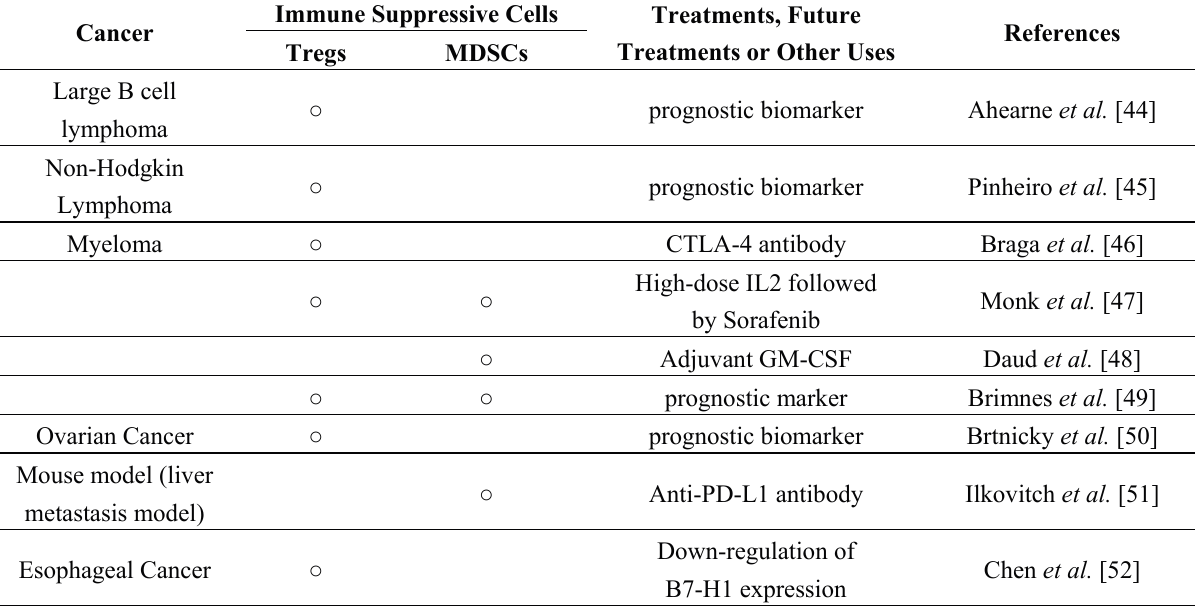
Table 2. Association of Tregs and MDSCs and other cancers except for